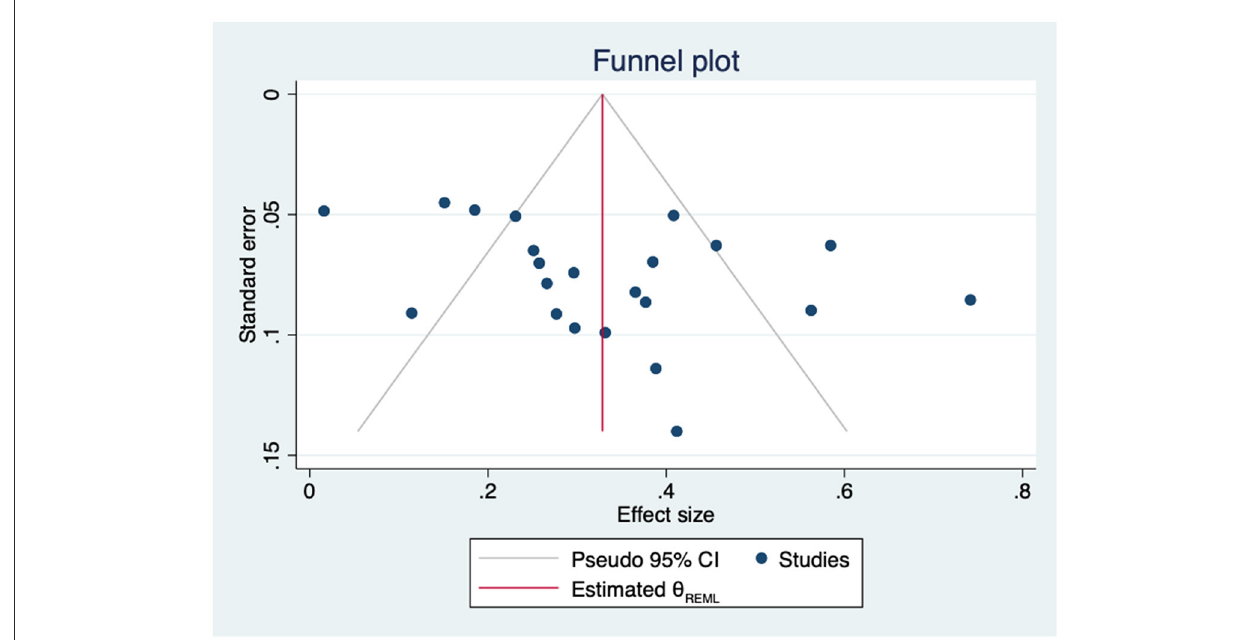
FIGURE10 Funnel plot for the association between empowerment and general QoL.